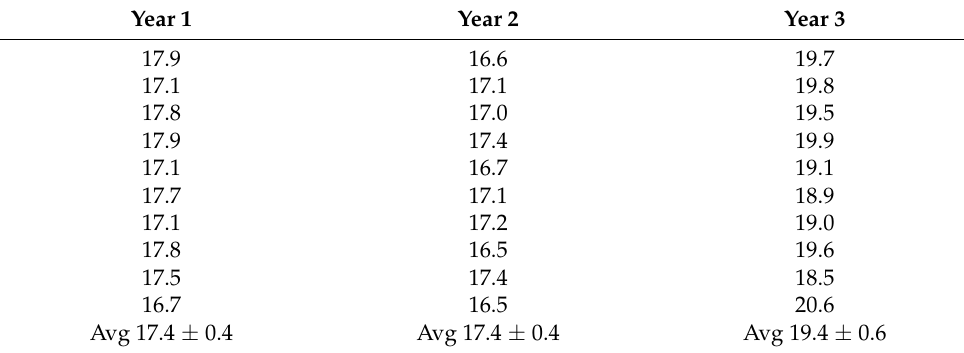
Table 3. Overall error of classification based on associations in subclinical mastitis prediction, based on 10-foldcross-validation